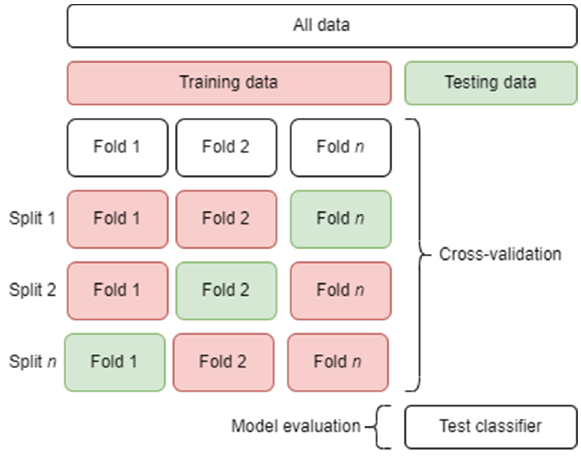
Figure 4. The k- fold cross-validation procedure with n folds. Figure 4. The k -fold cross-validation procedure with n